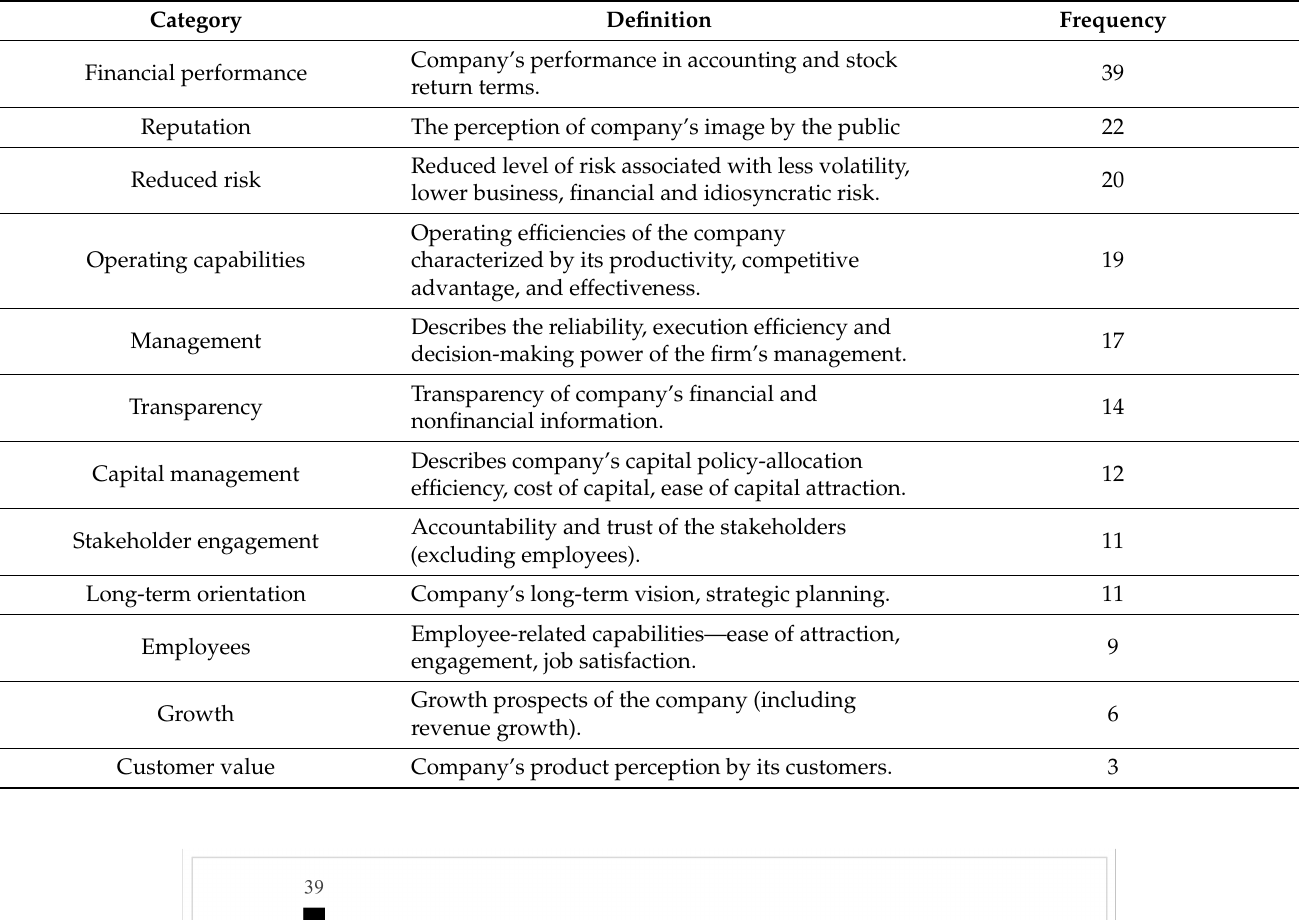
Table 2. Categories, definitions and the results of the content analysis—created by authors.